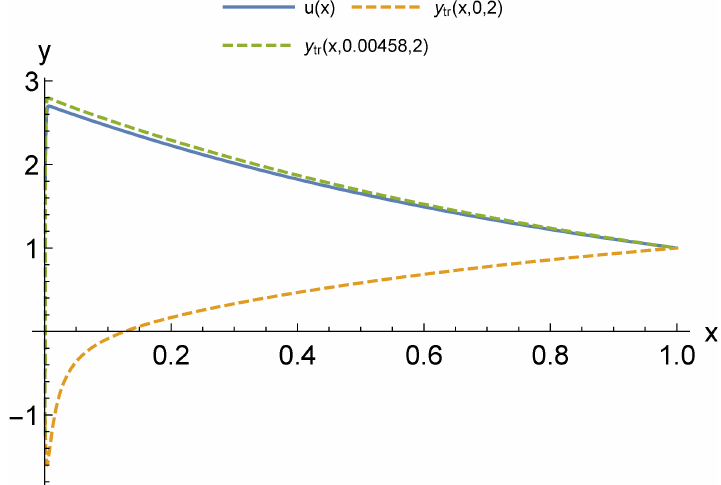
Figure 15. Plots of multilayer solutions y tr ( x ,0,2 ) , y tr ( x ,0.0048,2 ) (number of layers n = 2) as applied to problem (30) and its exact solution u ( x ) (parameter value s = 0.001), corresponding to dashed lines and solid line, respectively.